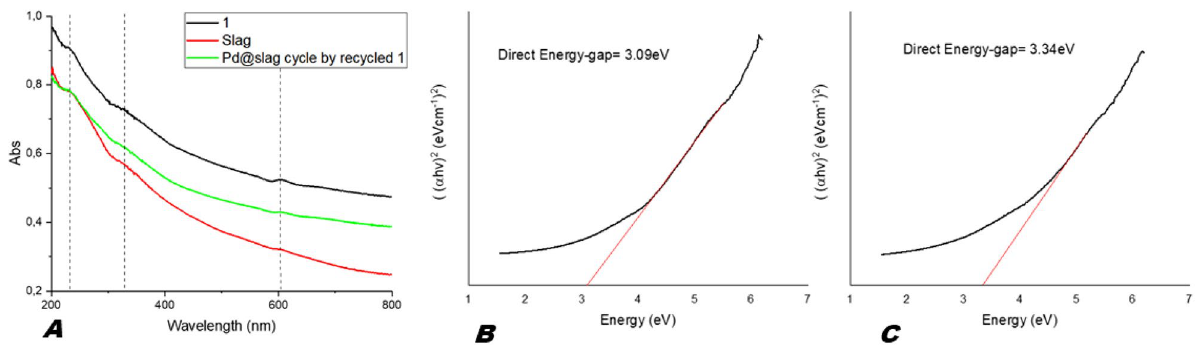
Figure 4. ( A ) UV–Vis DR spectra of slag and catalyst 1, ( B ) Energy gap for slag, ( C ) Energy gap for catalyst 1.